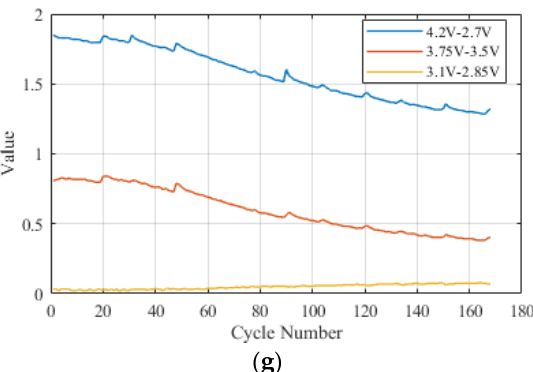
Figure 3. Extracted features of lithium-ion battery (B0005) discharge data: ( a ) E sv of full discharge data and PDD; ( b ) E st of full discharge data and PDD; ( c ) LP sv of full discharge data and PDD; ( d ) LP st of full discharge data and PDD; ( e ) µ sv of full discharge data and PDD; ( f ) µ st of full discharge data and PDD; ( g ) Ah of full discharge data and PDD.